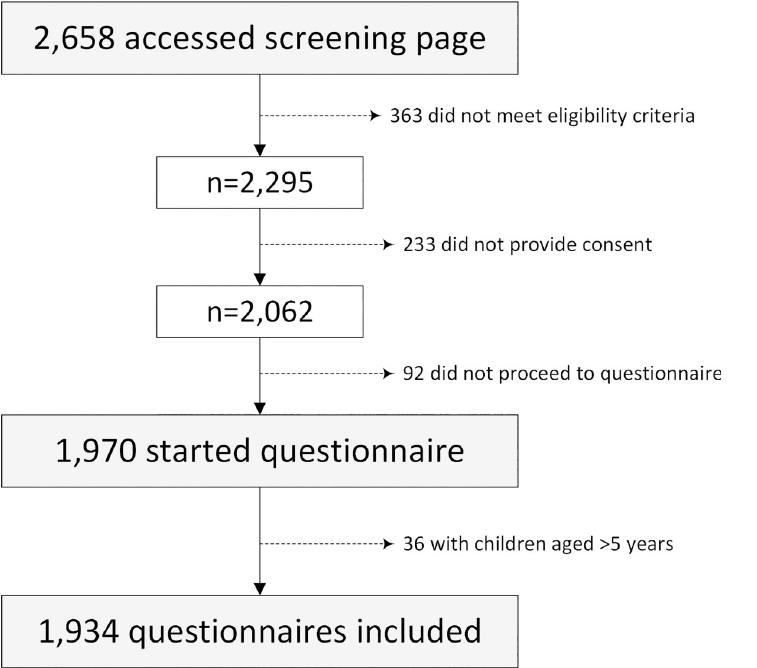
Fig 1. Flowchart document participants’ completion of online survey.